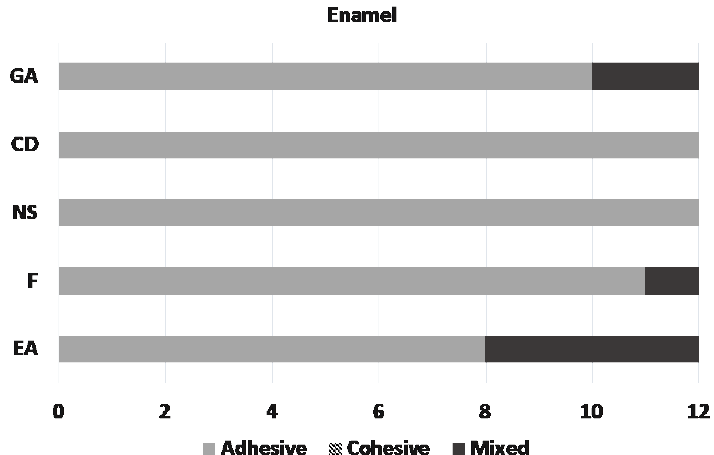
Figure 2. Distribution of the failure types on enamel.